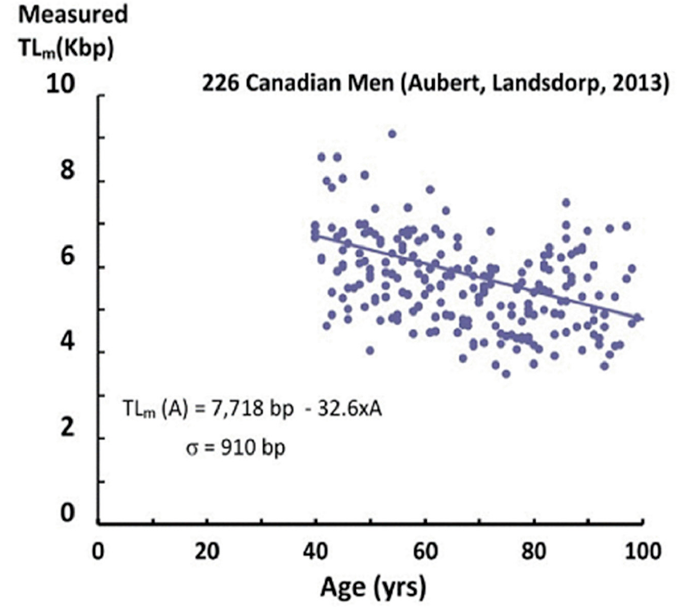
Figure 1. The measured telomere length (in kbp, thousands of base pairs) using the flow-FISH technique is plotted as a function of age for 226 Canadian males, along with a linear fit to the data.